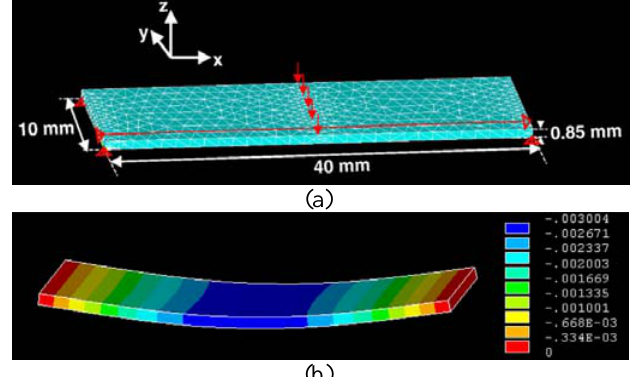
Fig. 3. (a) Loading conditions for the simulation of three- point bending test.